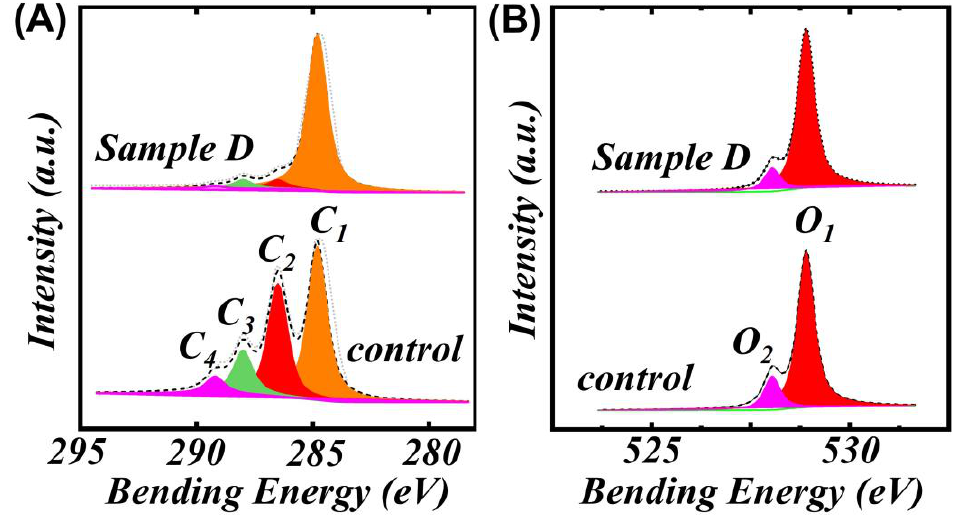
Figure 4. XPS curves of the different bamboo samples. ( A ) C1s of different bamboo specimens; ( B ) O1s of different bamboo samples.